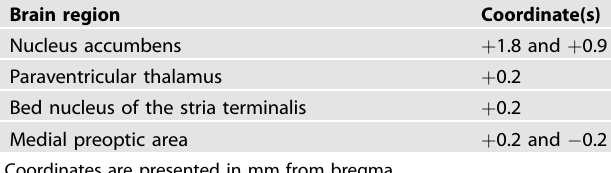
Table 4. Coordinate(s) for the selected brain regions sliced for the immunohistochemical staining. Brain region